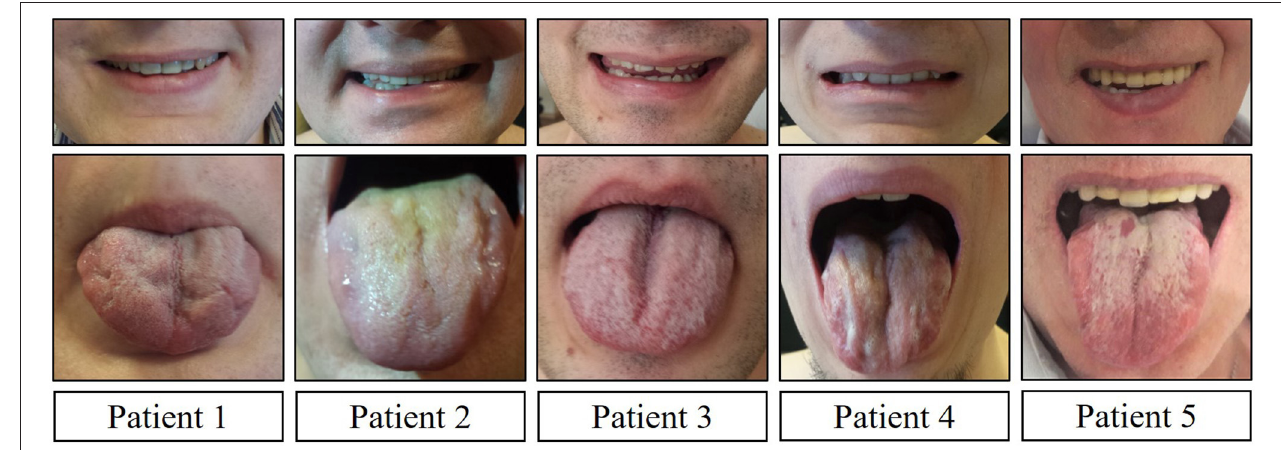
FIGURE 1 | Facial muscle weakness and tongue atrophy.